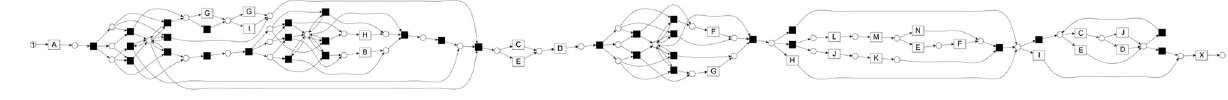
Fig 14. Result from ETM miner algorithm.